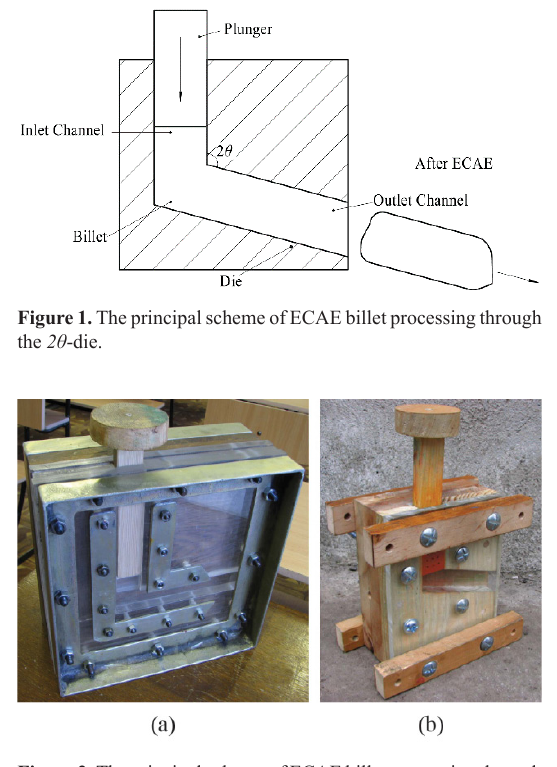
Figure 2. The principal scheme of ECAE billet processing through the 2θ -die model with 2θ=90° (a) and 2θ=105° (b).